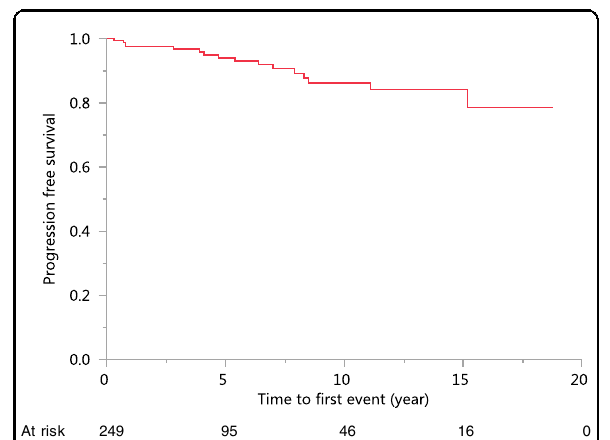
Fig. 2 Progression-free Survival of Young Patients with MGUS with or without Immune-related Conditions. The cumulative risk of progression at 1 year, 2 years, 3 years, 4 years, 5 years, and 10 years for patients without immune-related conditions is 5.7%, 5.7%, 7.7%, 10.0%, 12.3%,and 18.9%, for patients with immune-related conditions, is 0.0%, 0.0%, 0.0%, 0.0%, 1.5%, and 10.1%. (Wilcoxon p = 0.0158, log-rank p =